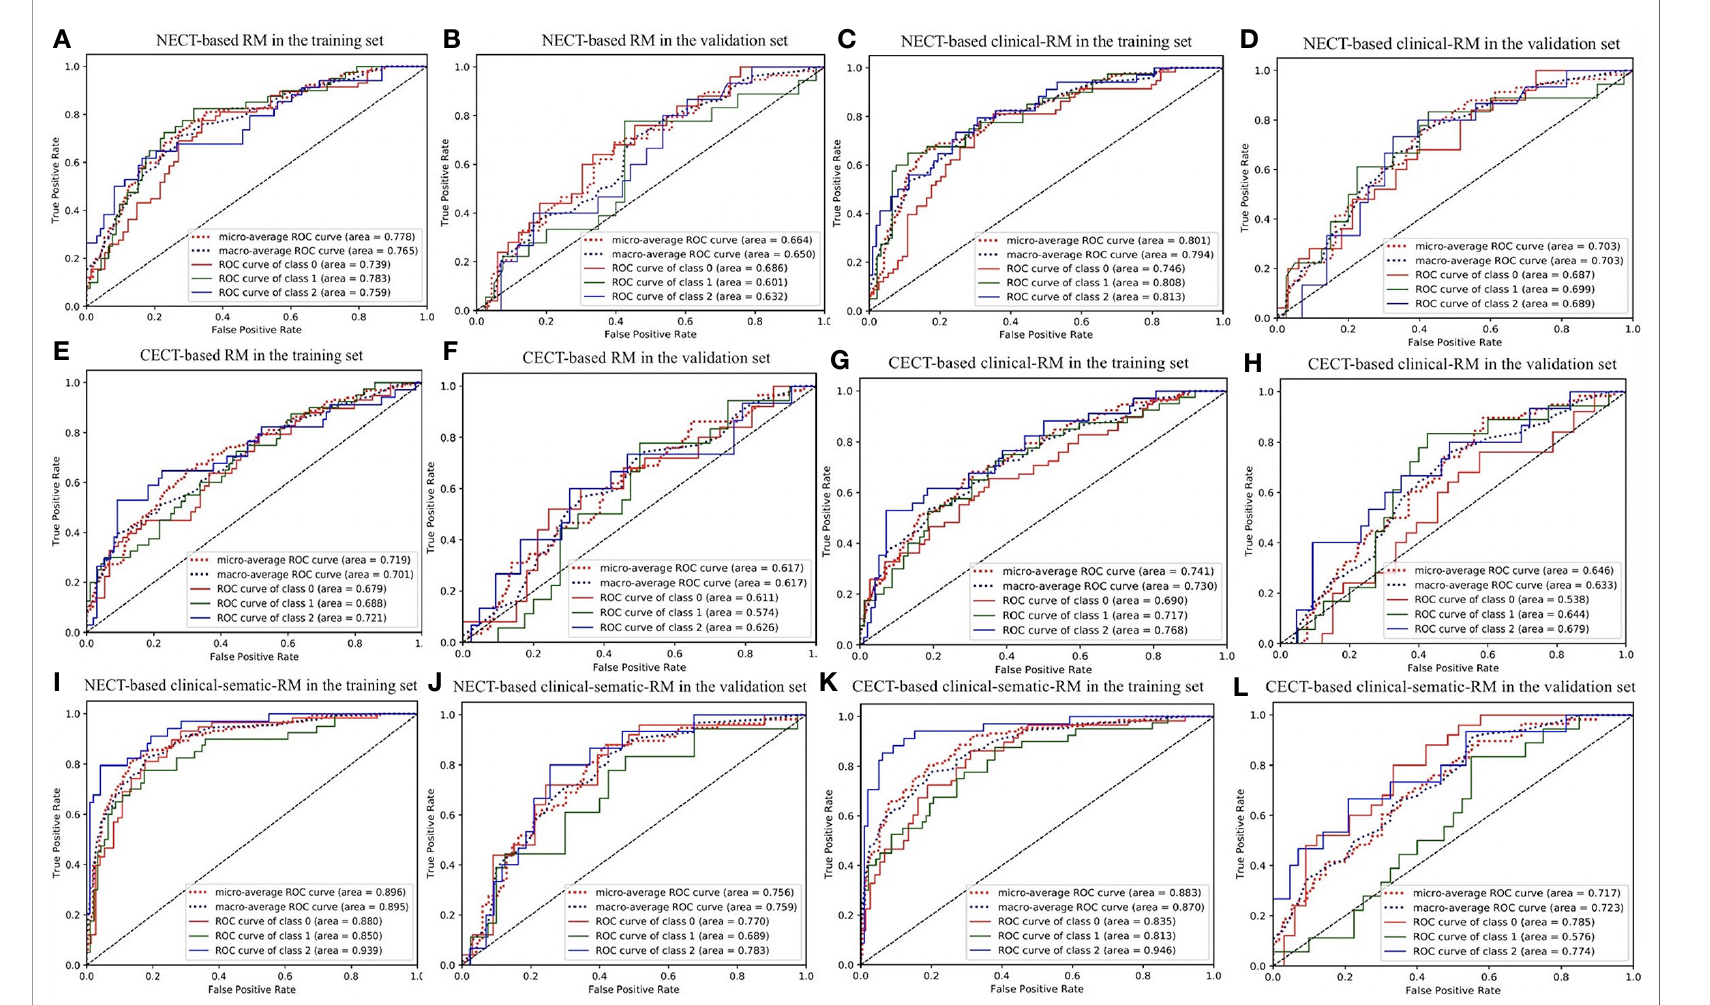
FIGURE 3 | The ROC curve of three-class models. (A, B) NECT-based RM in the training and validation sets; (C, D) NECT-based clinical-RM in the training and validation sets; (E, F) CECT-based RM in the training and validation sets; (G, H) CECT-based clinical-RM in the training and validation sets; (I, J) NECT-based clinical-sematic-RM in the training and validation sets; (K, L) CECT-based clinical-sematic-RM in the training and validation sets. Class 0, low-risk thymoma; class 1, high-risk thymoma; class 2, thymic